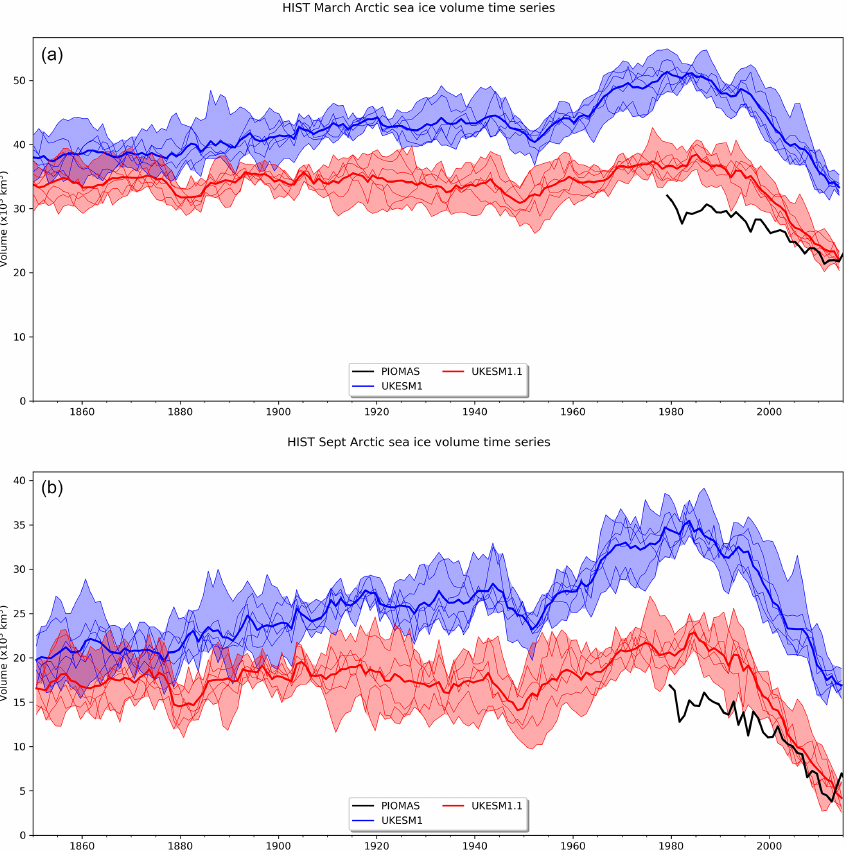
Figure 15. Time series of simulated (blue, UKESM1; red, UKESM1.1) sea ice volume in the Arctic for the months of (a) March and (b) September over the full historical period (1850–2014) along with the Pan-Arctic Ice Ocean Modeling and Assimilation System (PIOMAS) reanalysis data (black). Model data represent the ensemble mean for UKESM1 (six members) and UKESM1.1 (six members), with the ± 1 standard deviation also shown.